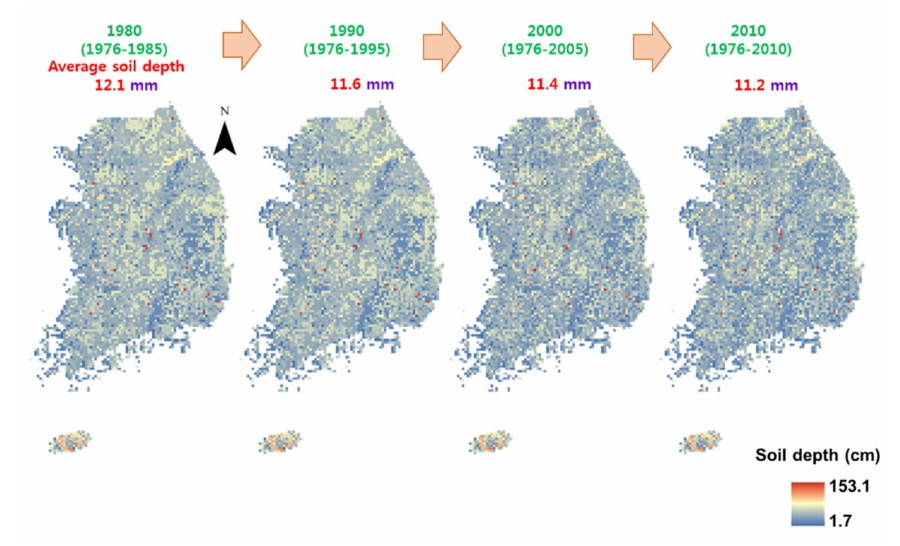
Figure A3. Soil depth (SD) distribution map for the study